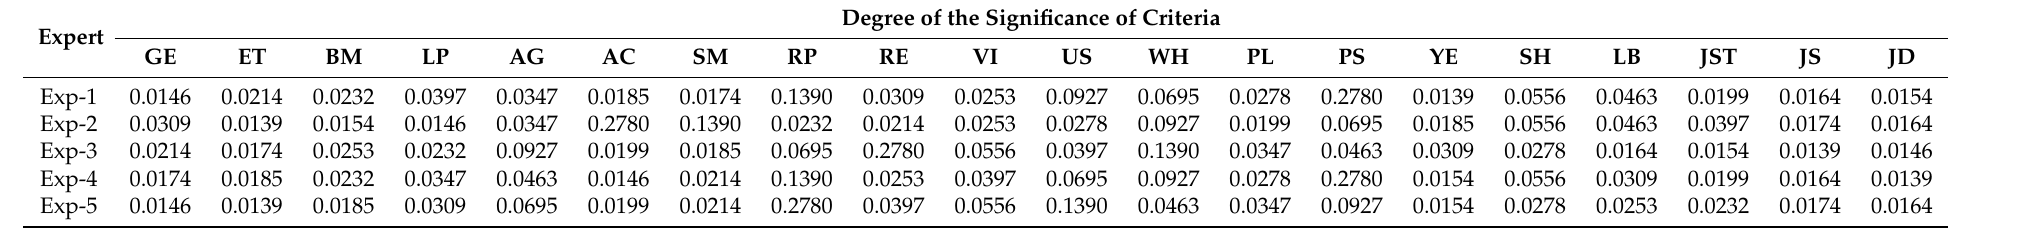
Table 8. Importance value of each risk factor from the perspective of each